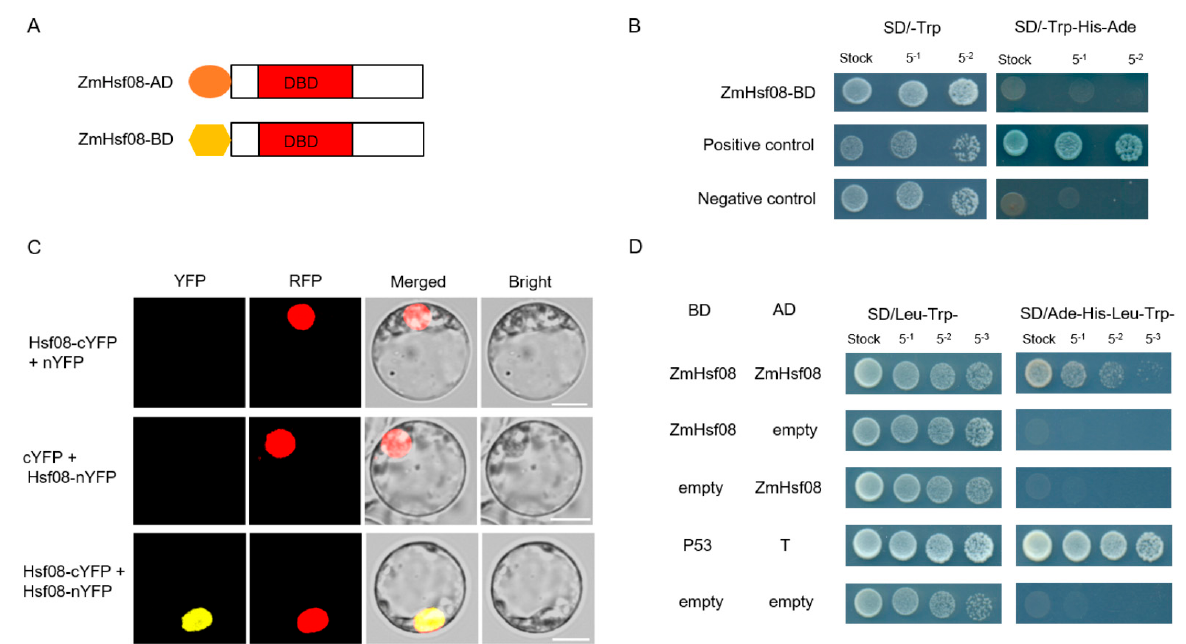
Figure 8. Homodimerization of ZmHsf08 . ( A ) Schematic representation of the structures of ZmHsf08 -AD and ZmHsf08 -BD. ( B ) The transcriptional activation activity assay in yeast cells. ( C ) Bimolecular fluorescence complementation (BiFC) assay of the homodimerization of ZmHsf08 in maize protoplasts. Different combinations of the nYFP and cYFP fusion constructs were cotransformed into maize protoplasts, and the fluorescence signals were examined with a confocal microscope. ( D ) Yeast two-hybrid (Y2H) analysis of the self-interaction of ZmHsf08 . AD, GAL4 activation domain; BD, GAL4 DNA binding domain; Protein–protein interactions were examined by yeast cell growth on the SD/-Leu/-Trp/-His/-Ade plate.